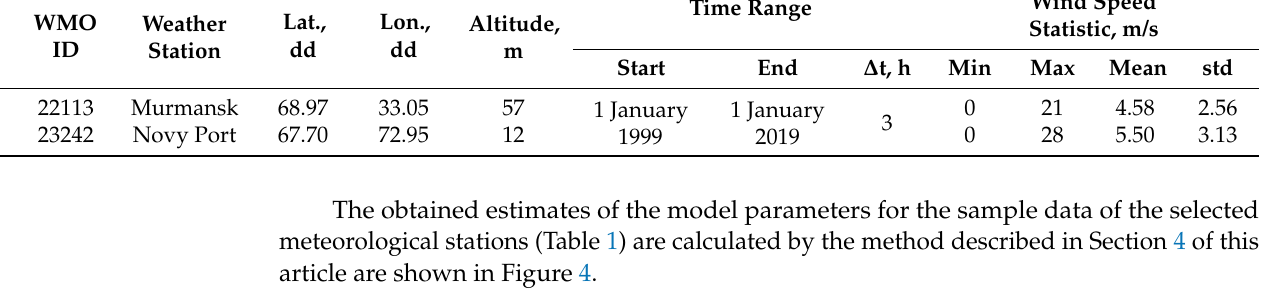
Table 1. Weather stations data.